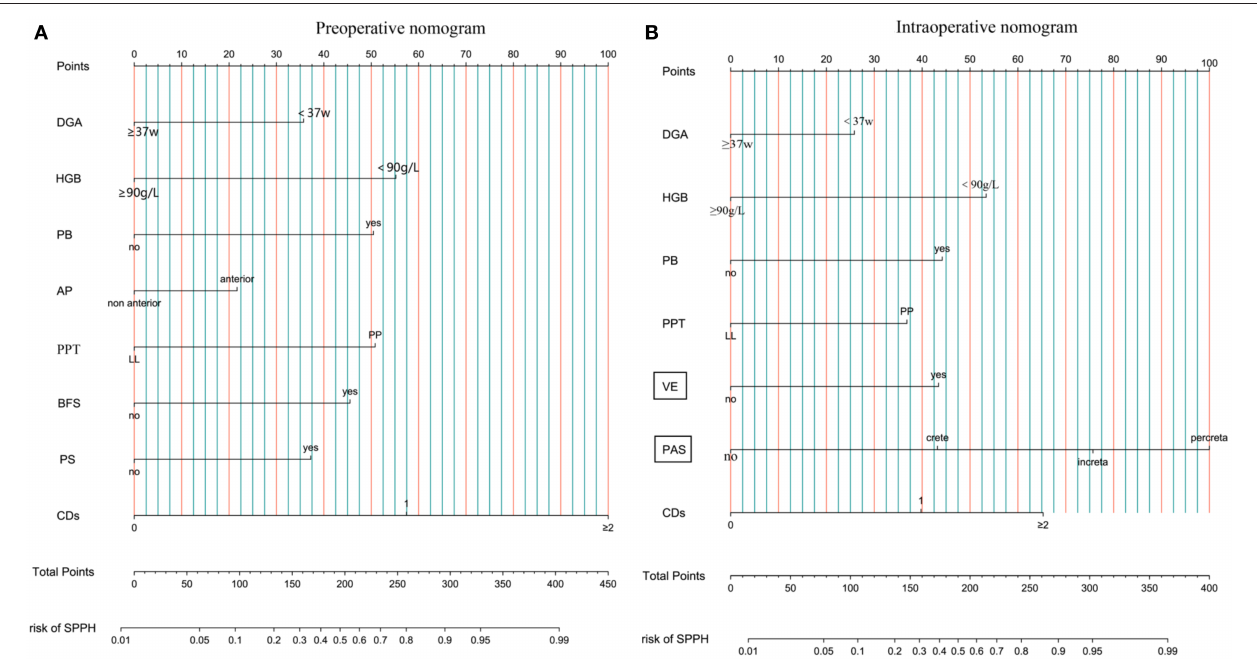
FIGURE 2 | Nomogram. (A) Preoperative nomogram. (B) Intraoperative nomogram. DGA, delivery gestational age; HGB, hemoglobin; PB, preoperative bleeding; AP, anterior placenta; PPT, placenta previa type; LL, low-lying; PP, placenta previa; BFS, blood flow signal of lower uterine segment; PS, placental sinuses; CDs, number of prior cesarean delivery; VE, vascular engorgement of lower uterine segment; PAS, placenta accrete spectrum; SPPH, severe postpartum